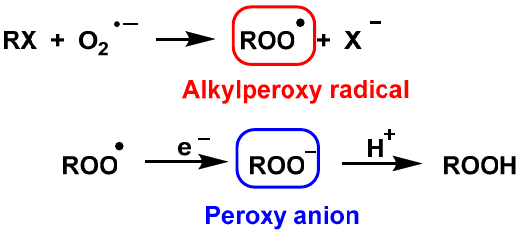
Figure 47. Formation of alkylperoxy radicals and peroxy anions.